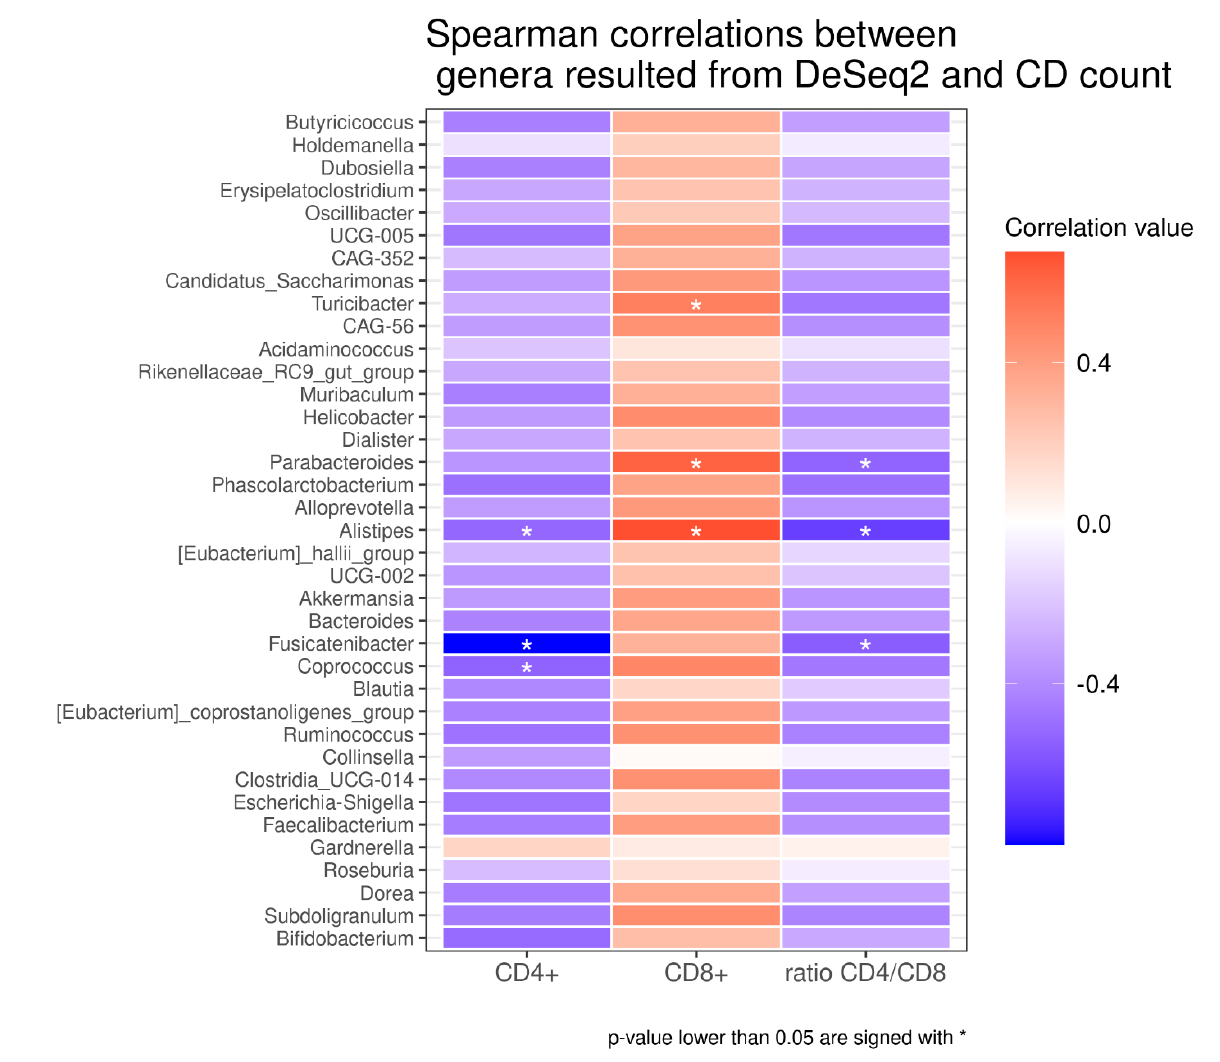
FIGURE 4: Heatmap of Spearman correlation between the differential abundant genera and Tcc expressions (CD4+, CD8+, ratio CD4/CD8). Colours indicate the rho of Spearman’s coefficient and the asterisk (*) denotes a correlation with p value lower than 0.05. Red shades indi- cate positive correlations, whereas blue shades indicate negative correlations. (Tcc= T cell OPEN ACCESS | www.microbialcell.com 43 Microbial Cell | FEBRUARY 2023| Vol. 10 No. 2